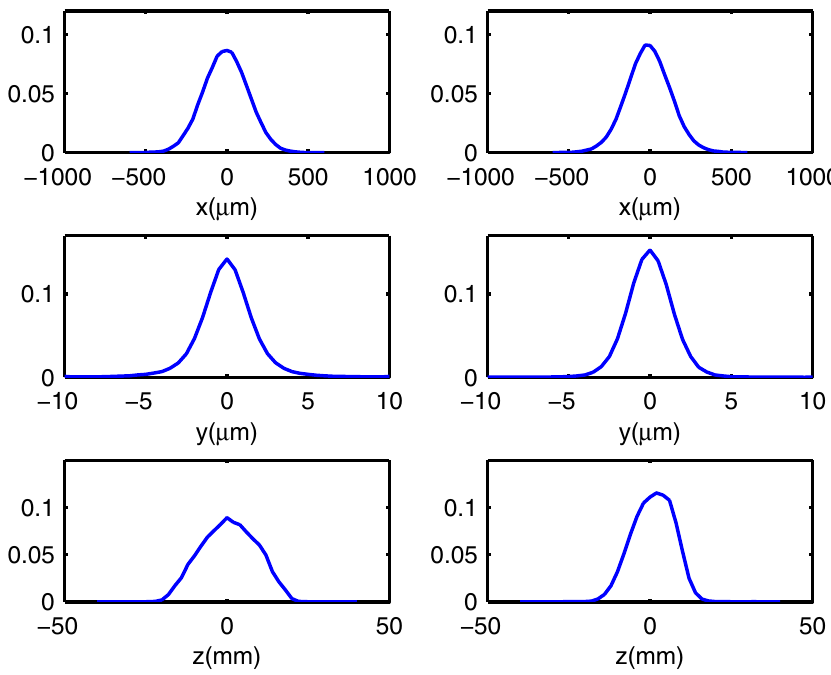
FIG. 11. (Color) Equilibrium distributions of colliding bunches at 1 : 38 mA = 0 : 80 mA . Left columns are positron bunch and right for electron